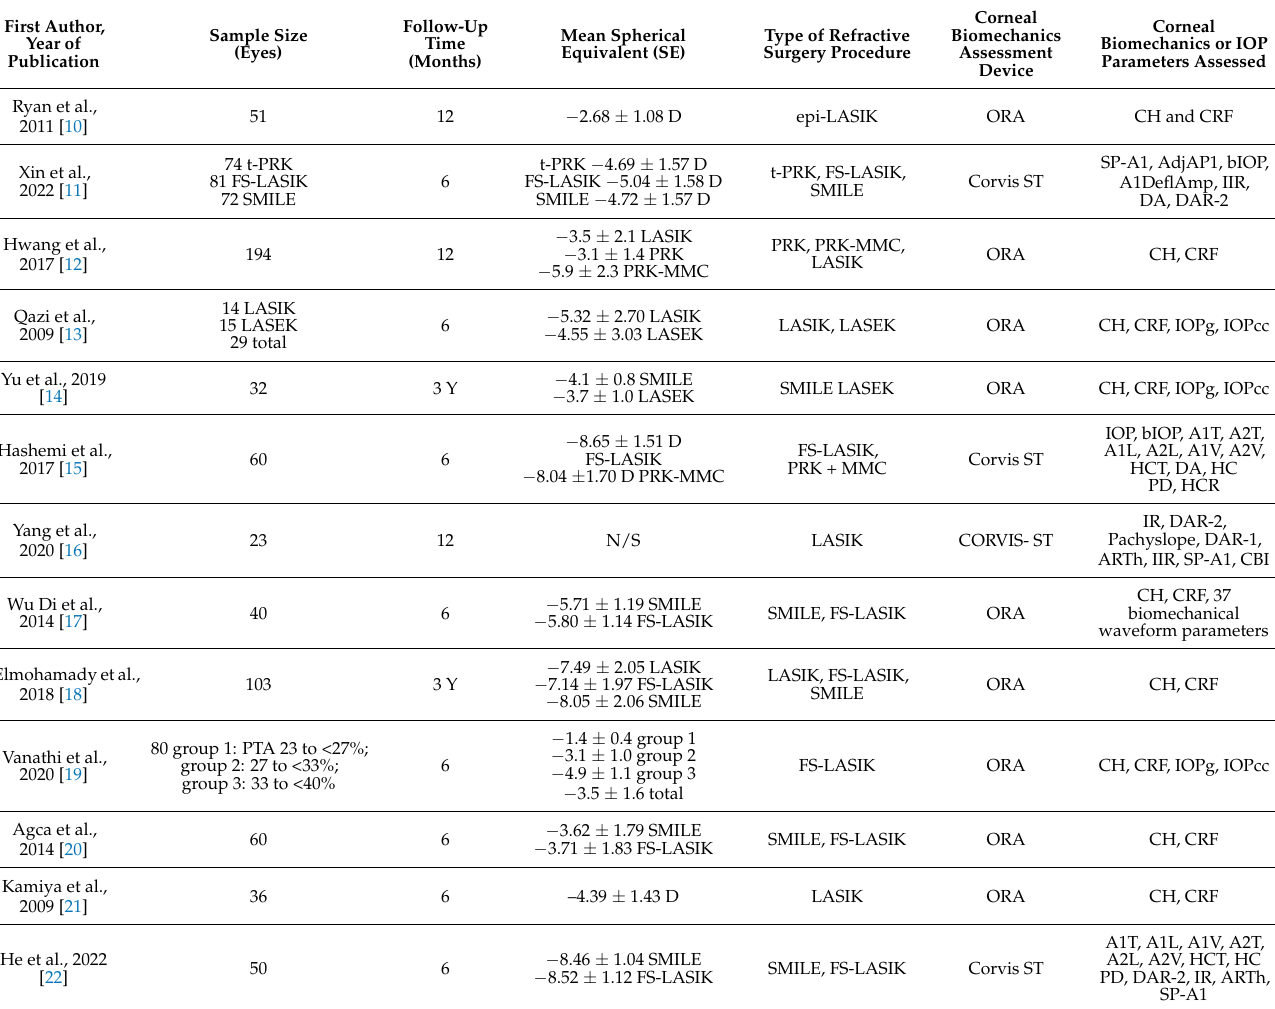
Table 1. Characteristics of prospective studies included in the systematic